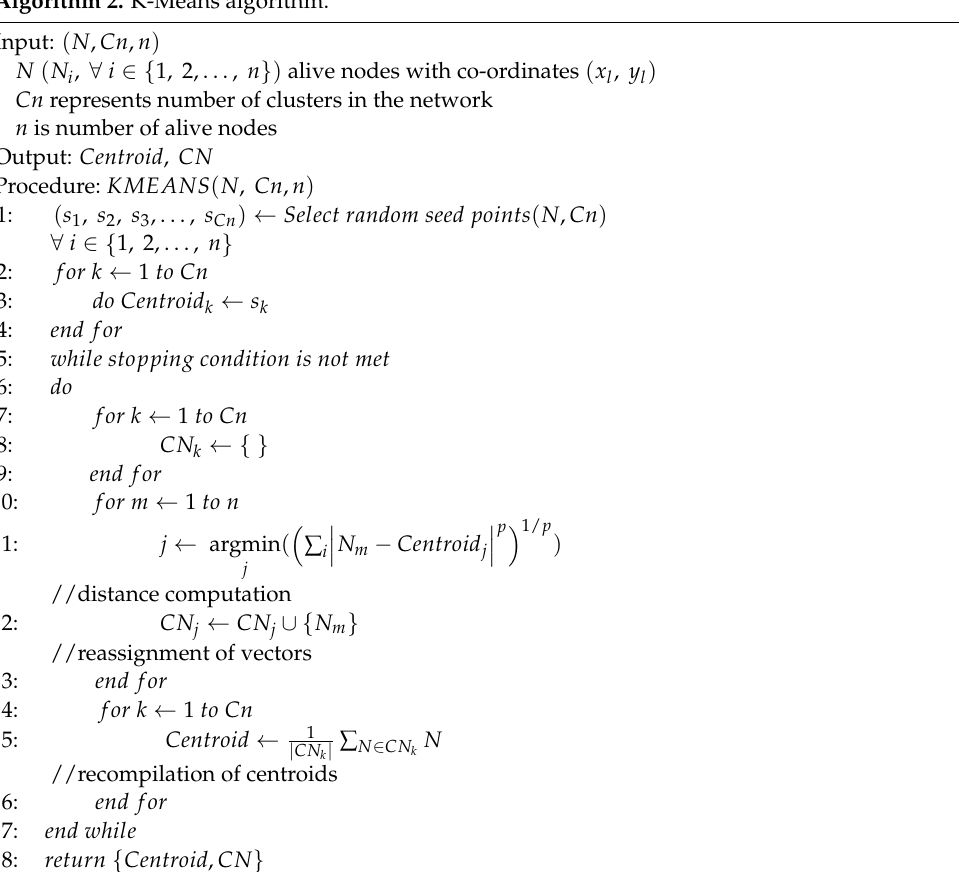
Algorithm 2. K-Means